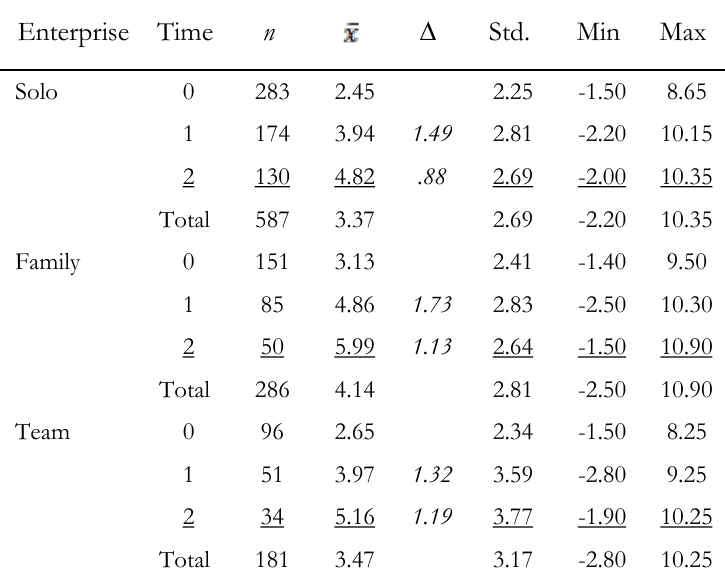
Table 1. Firm Emergence Means by